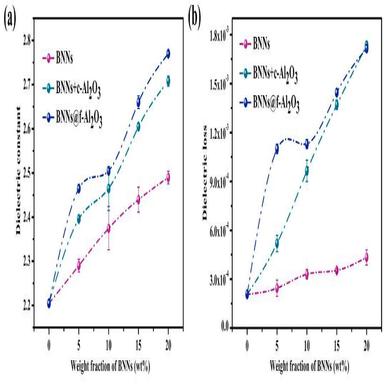
(a, b) The dielectric constant and dielectric loss of BNNs, BNNs + c-Al2O3 and BNNs@f-Al2O3 filled COC composites under 10 GHz.